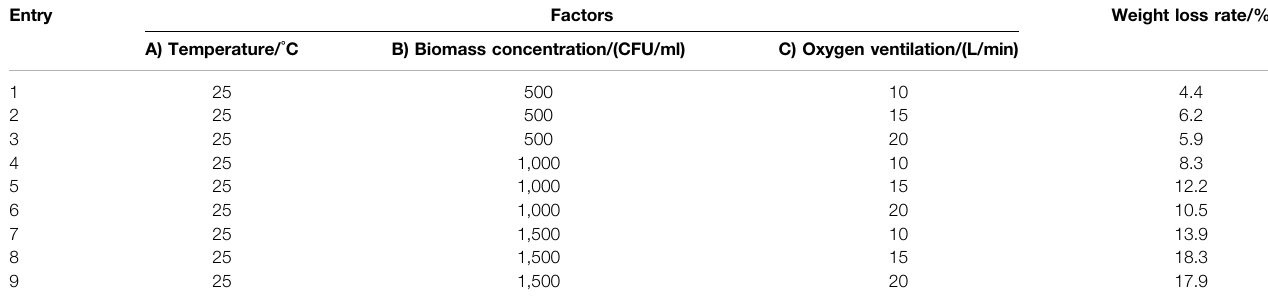
TABLE 1 | The weight loss rate under different factors and levels of the orthogonal test. Entry Factors Weight loss